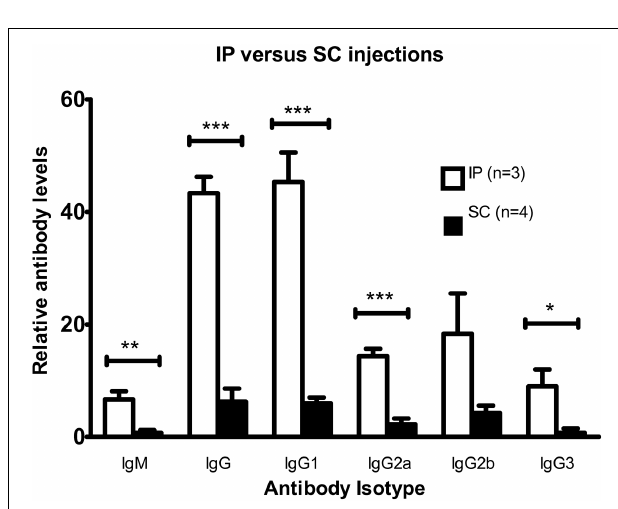
FIGURE 3 | Comparison of antibody responses for intraperitoneal and multiple sites subcutaneous injections with DFTD cells . Mean fluorescence intensity ratio of samples compared to pooled naïve mouse serum was used as a relative measure of antibody expression. C57BL/6 mice were injected with 10 6 DFTD cells on day 0 and 16 with serum collected on day 25.The SC cohort received SC injections divided between the neck and rump region to target multiple draining lymph nodes (Data are expressed as mean ± SEM; probability calculated by an unpaired Student’s t -test, * P < 0.05, ** P < 0.01, and *** P < 0.001).